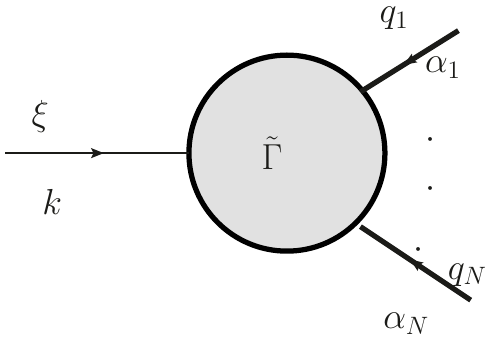
Figure 3 . An amputated Greens function with N-number of external (cid:12)nite energy particles and one soft particle. This diagram represents sum over the diagrams where the soft particle is not attached to any external